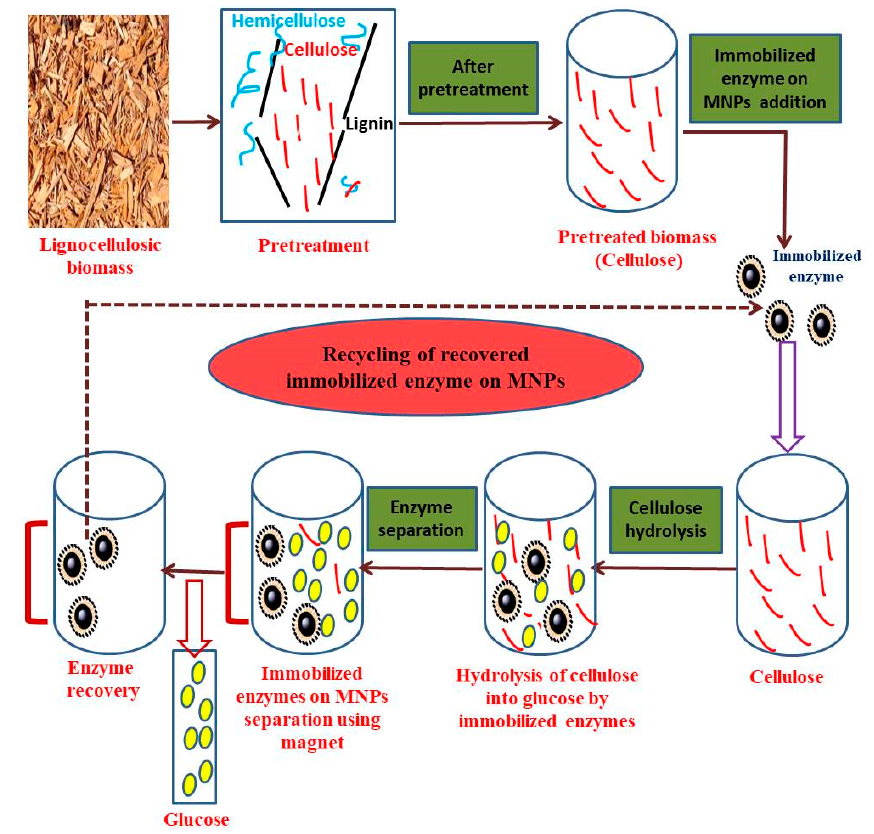
Figure 2. Schematic representation of LB-derived cellulose hydrolysis using immobilized enzymes on magnetic nanoparticles and their recovery after hydrolysis into simple sugars.